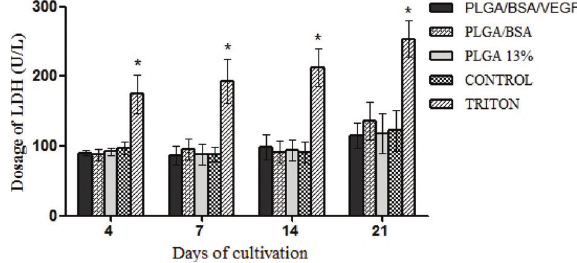
Figure 6. Evaluation of the metabolically active cells by MTT assay, tested on the following scaffold groups: PLGA/BSA/VEGF, PLGA/BSA, 13% PLGA and the control (cells cultivated directly on the cultivation well plates). Data are reported as means ± SD. *P o 0.05, repeated measures with post-hoc Bonferroni. PLGA: polylactic-co-glycolic acid; BSA: bovine serum albumin; VEGF: vascular endothelial growth factor.